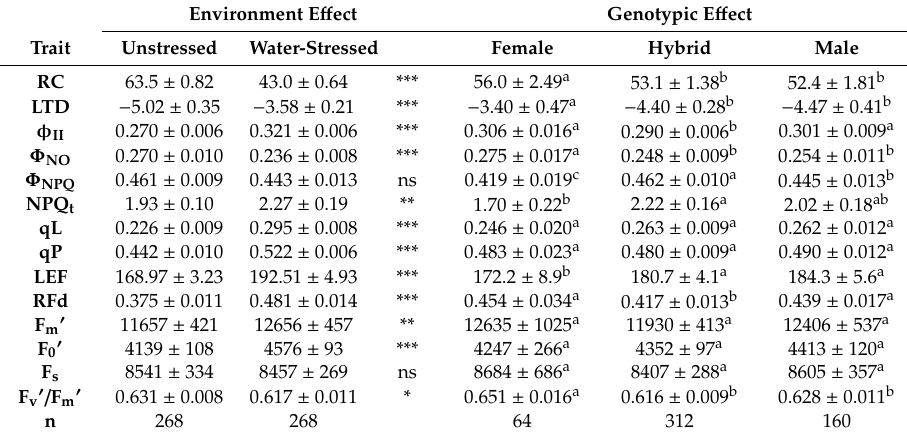
Table 3. Mean ± 95% confidence intervals of MultispeQ-derived traits, sorted by environment (unstressed vs. water-stressed) and genotypic set (female, hybrid, and male). Environment means are averaged for all genotypes. Genotypic means are averaged for the two environments. Asterisks indicate significantly di ff erent environment means at P < 0.05 according to overall ANOVA. Genotypic set means with di ff erent letter are significantly di ff erent at P < 0.05 according to means separation by